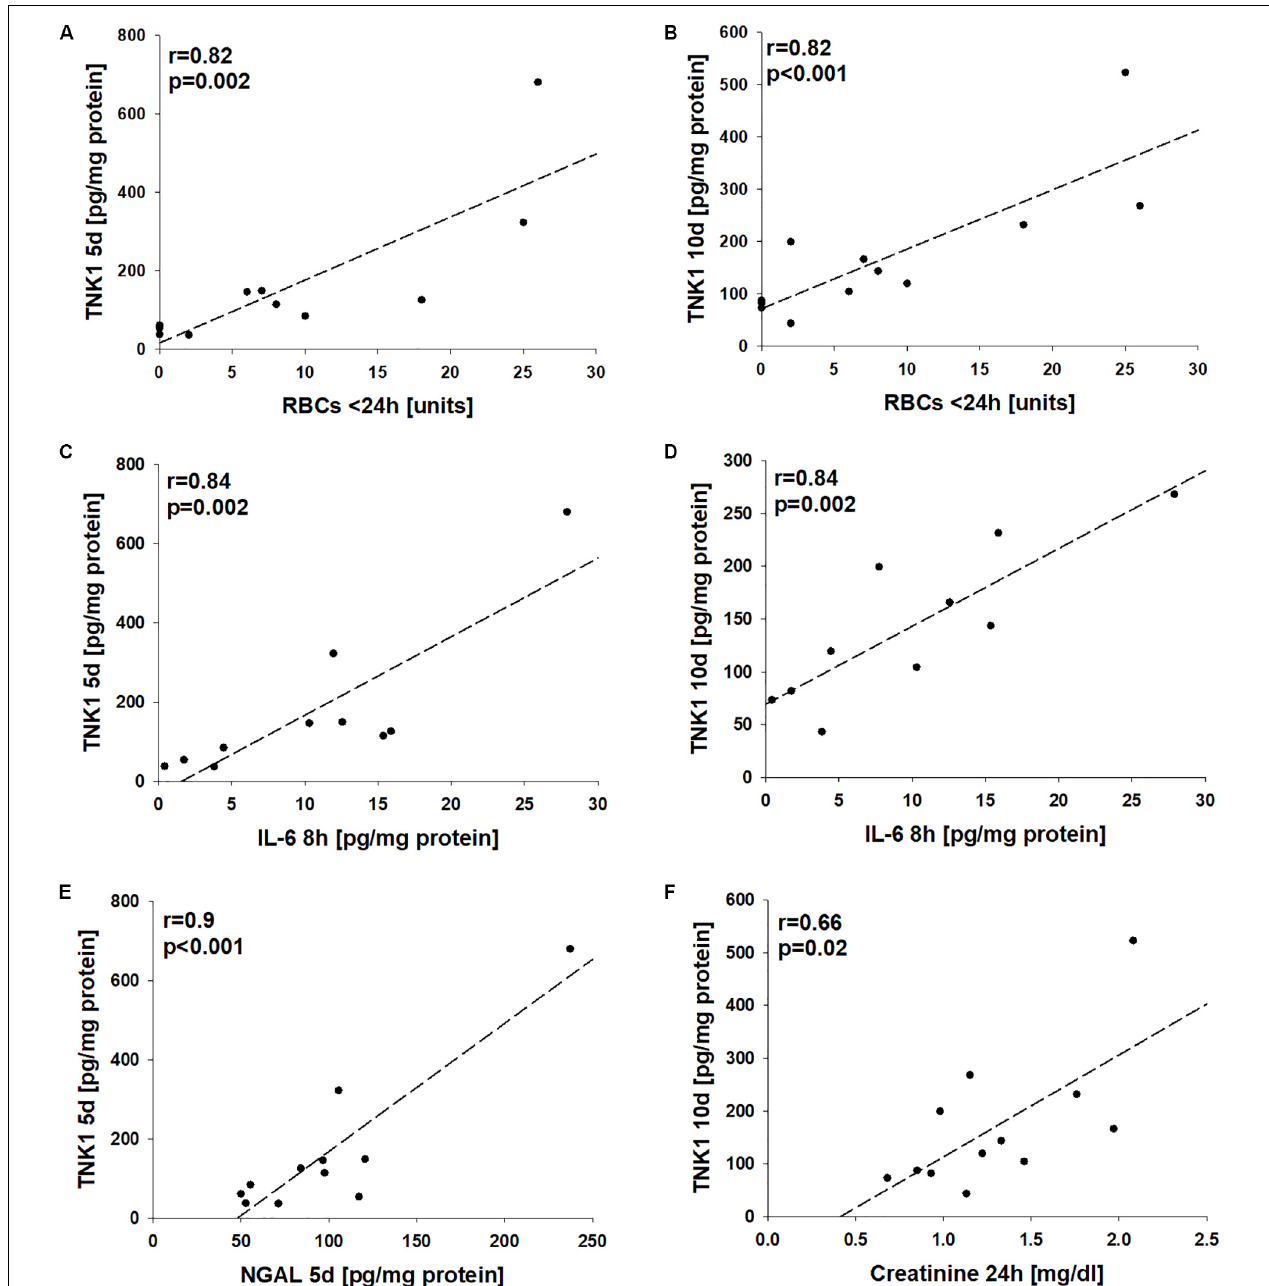
FIGURE 6 | Association of non-receptor tyrosine-protein kinase 1 (TNK1)-mediated kidney injury with systemic inflammatory markers. Correlation analyses were performed for plasma values of TNK1 with parameters related to hemorrhagic shock (HS), inflammation, and kidney dysfunction in severely injured patients. The numbers of applied red blood cell concentrates (RBC) during the first 24 h were significantly correlated with plasma TNK1 5 days (A) and 10 days after trauma (B) . Similarly, early levels of interleukin 6 (IL-6, 8 h after injury) significantly correlated with TNK1 5 days (C) and 10 days after trauma (D) . The plasma kidney injury marker neutrophil gelatinase-associated lipocalin (NGAL) was significantly correlated with TNK1 levels on day 5 (E) . Furthermore, plasma creatinine 24 h after injury was associated with TNK1 on day 10 (F) . r , Pearson correlation